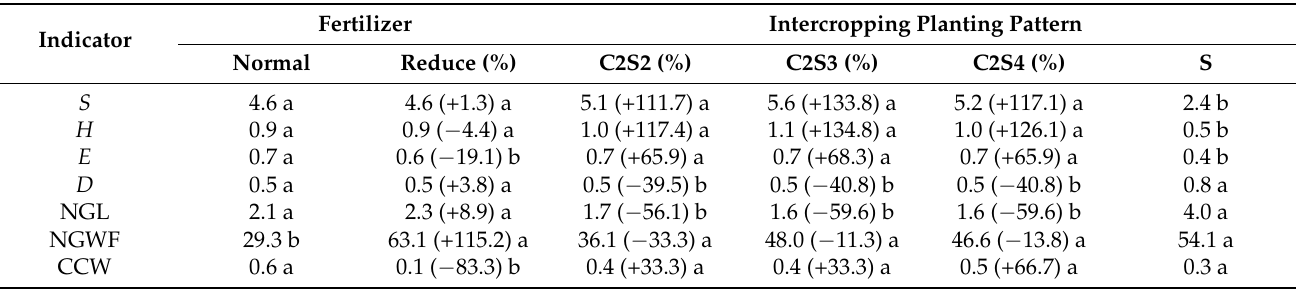
Table 8. Mean community diversity indices of each survey and the number of green leafhoppers, greenhouse whiteflies and common cutworms per 10 plants in every survey under normal and reduced fertilizer conditions under four intercropping planting patterns.